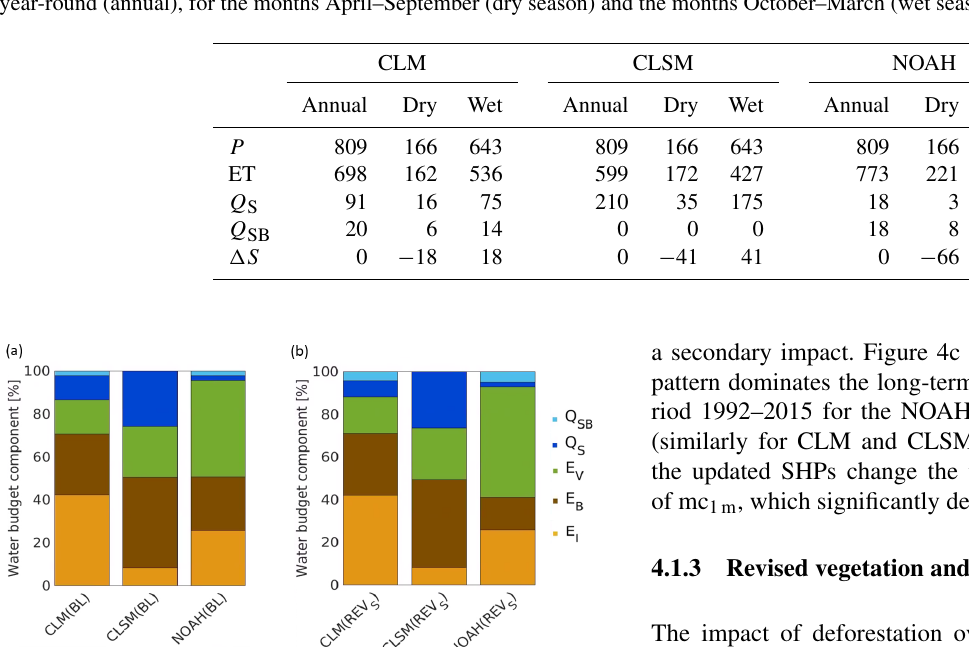
Table 2. Long-term (1992–2015) distribution of the BL water budget components (mm) for CLM, CLSM and NOAH over the Dry Chaco,